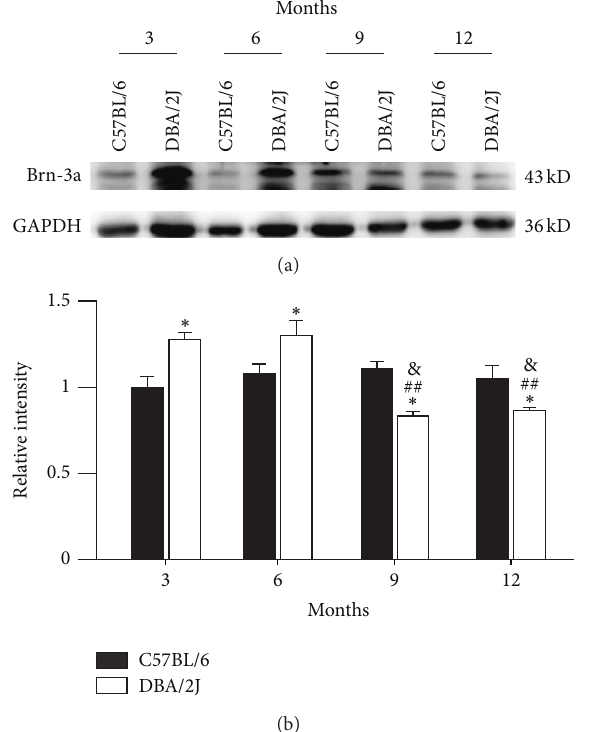
Figure 4: Changes in expression of Brn-3a of DBA/2J mice at various ages. (a)RepresentativeimmunoblotsshowingthechangesofBrn-3a levels in DBA/2J and C57BL/6 mice at ages of 3, 6, 9, and 12 months. (b) Bar chart showing the average densitometric quantification of immunoreactive bands of Brn-3a in DBA/2J and C57BL/6 mice at ages of 3, 6, 9, and 12 months, respectively. ∗ 𝑃 < 0.05 versus 3- month-old C57BL/6 mice; ## 𝑃 < 0.01 versus 3-month-old DBA/2J mice; & 𝑃 < 0.05 versus age-matched C57BL/6